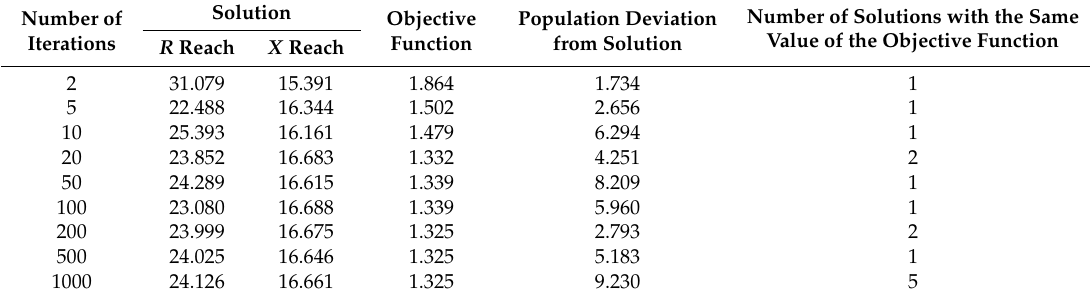
Table 7. Performance tests of the GA with a preference factor k = 0.95 and a mutation rate of 0.1. Solution Objective Number of Population Deviation Iterations Function from Solution